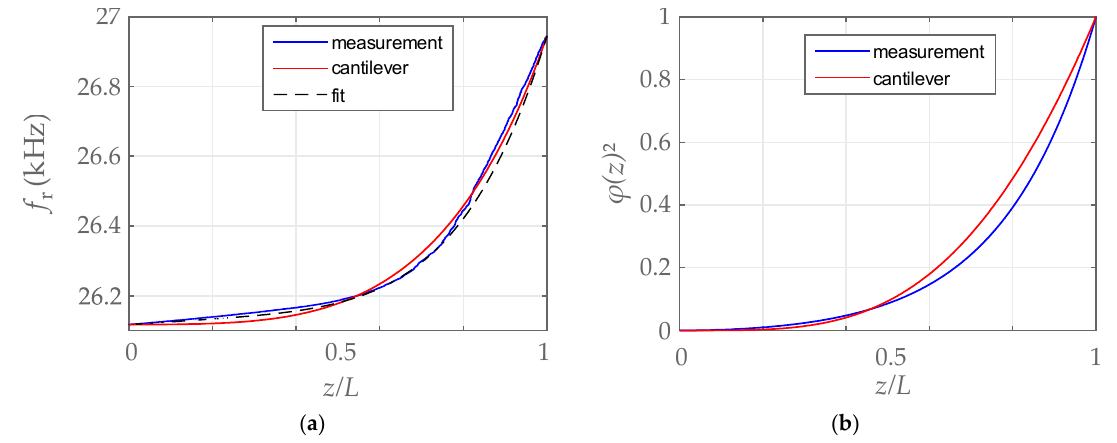
Figure 3. ( a ) Measured resonance frequency (approx. 35.000 points) and comparison to cantilever; ( b ) mode shape calculated using Equation (4) resembling the fundamental cantilever